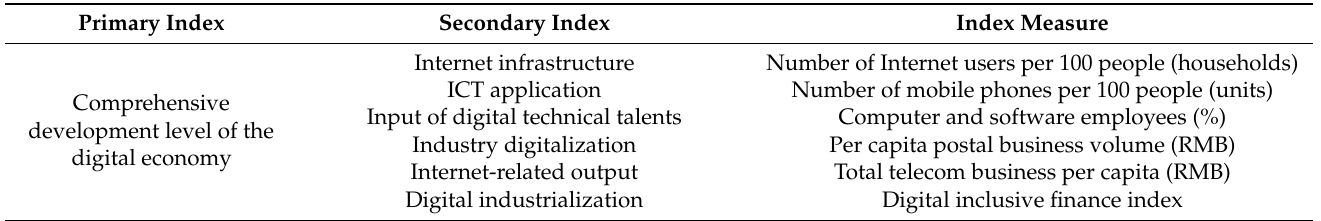
Table 1. Evaluation index system of comprehensive development level of the digital